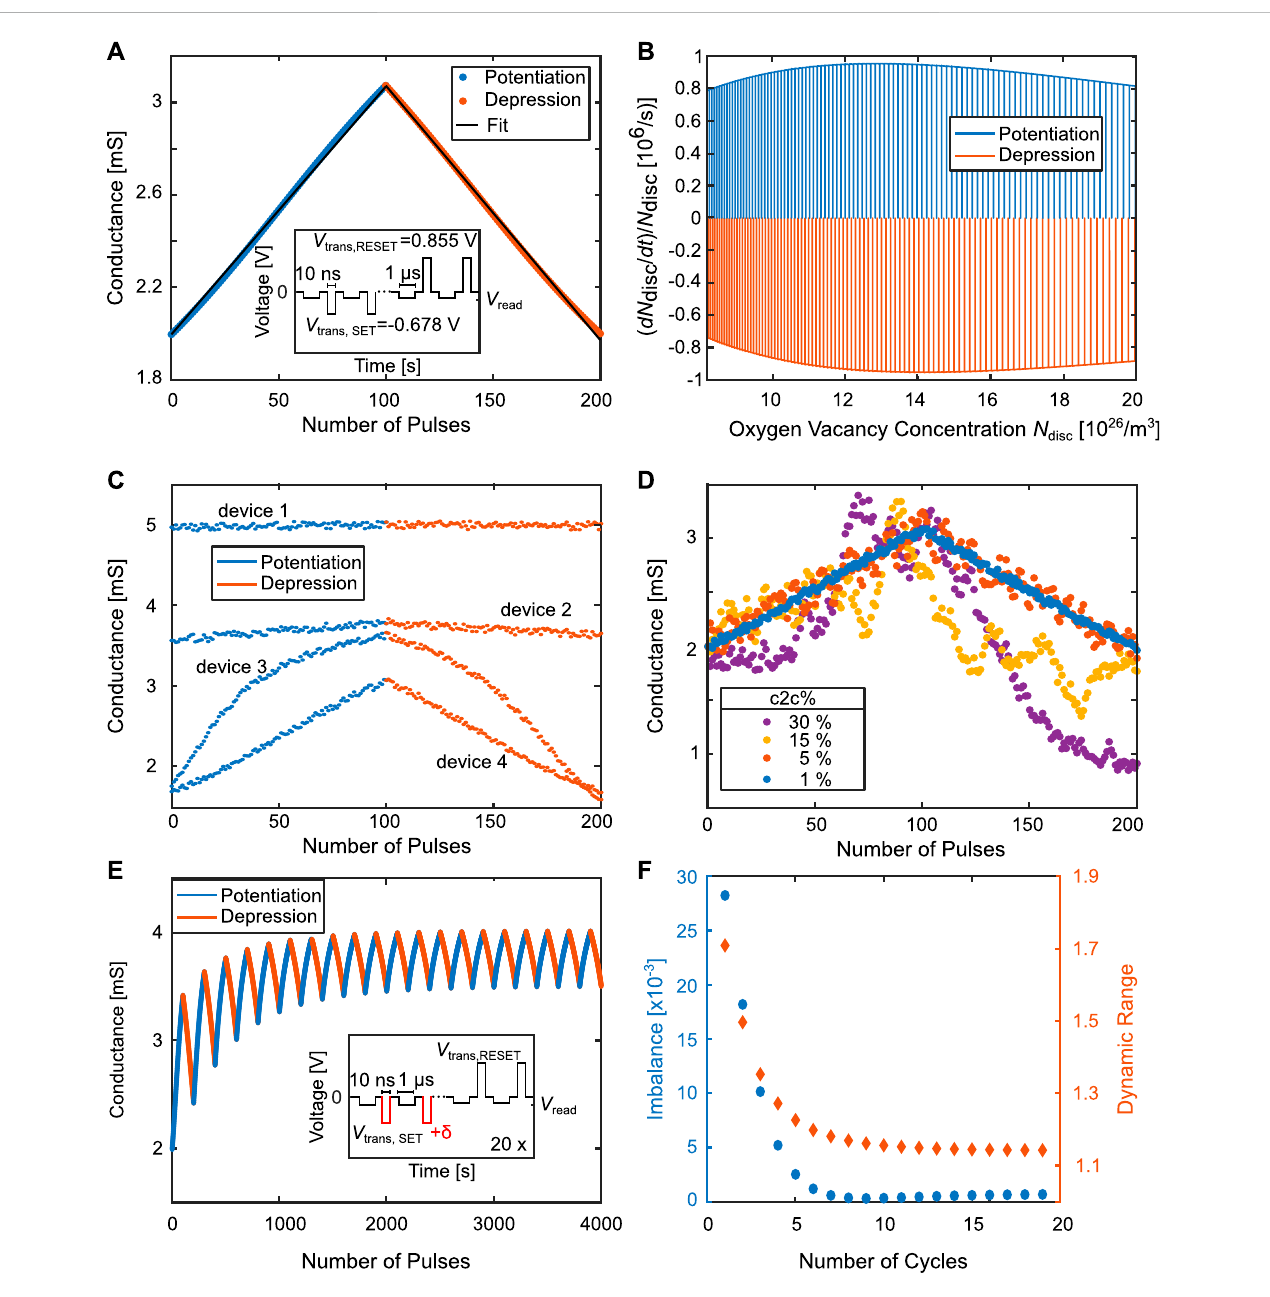
FIGURE 4 Simulations of the synaptic dynamics of the linear regime (A) with its calculated normalized DRM (B) . (C) shows the simulated effect of d2d variability on the conductance evolution during potentiation and depression, within the linear regime. (D) shows the simulated deterioration of the operation in the linear regime due to the c2c percentage. For (C) and (D) we used the optimized device with reduced d2d variability (section 2.1). Simulations of the cyclability of the linear regime for the case of a slightly too strong SET operation (E) resulting in a decreased dynamic range and a reduced imbalance (F)